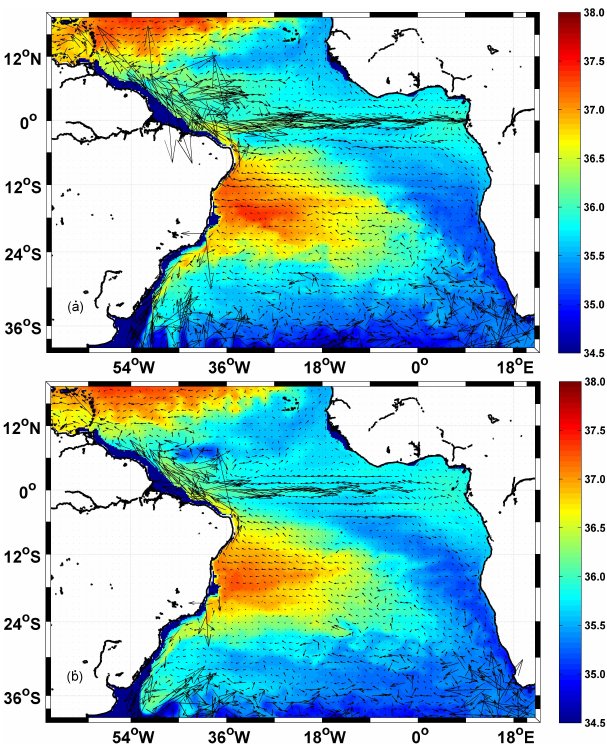
Fig. 4. Spatial distribution of isothermal layer depth ( Z T ) during: (a) late austral winter (August–October 1995); and (b) austral sum- mer (January–April